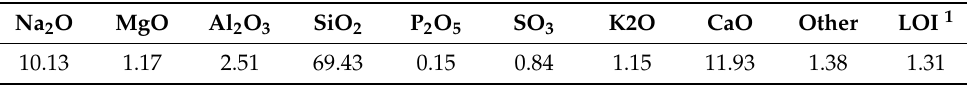
Table 3. Chemical composition of the studied GP